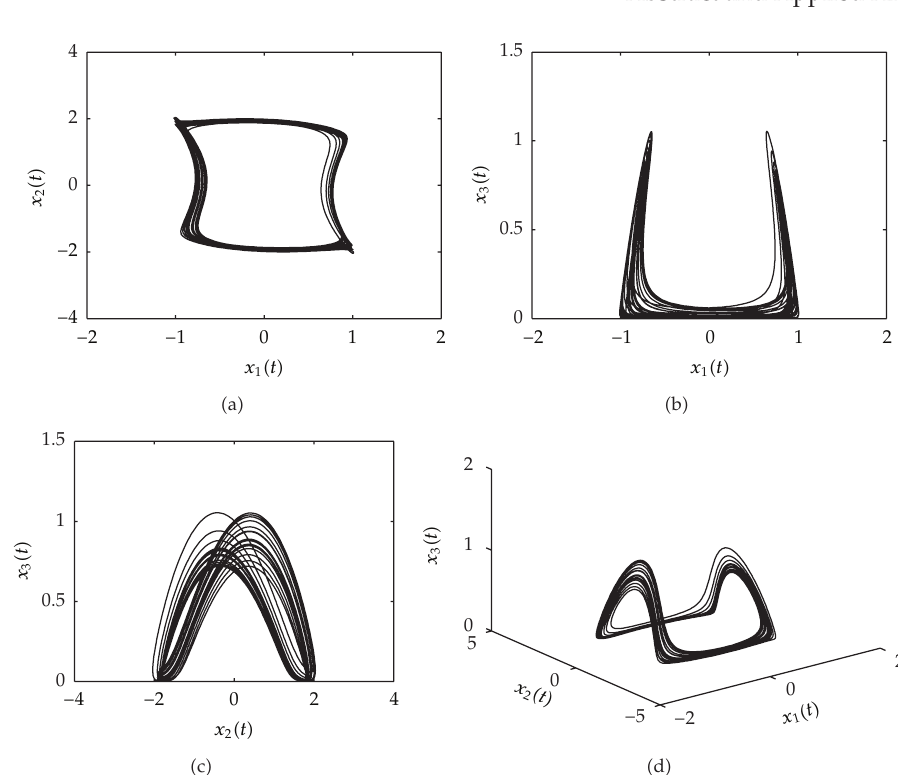
Figure 10: Phase plots for the Rabinovich-Fabrikant equations for a (cid:9) 0 . 1 and b (cid:9) 0 . 2715.